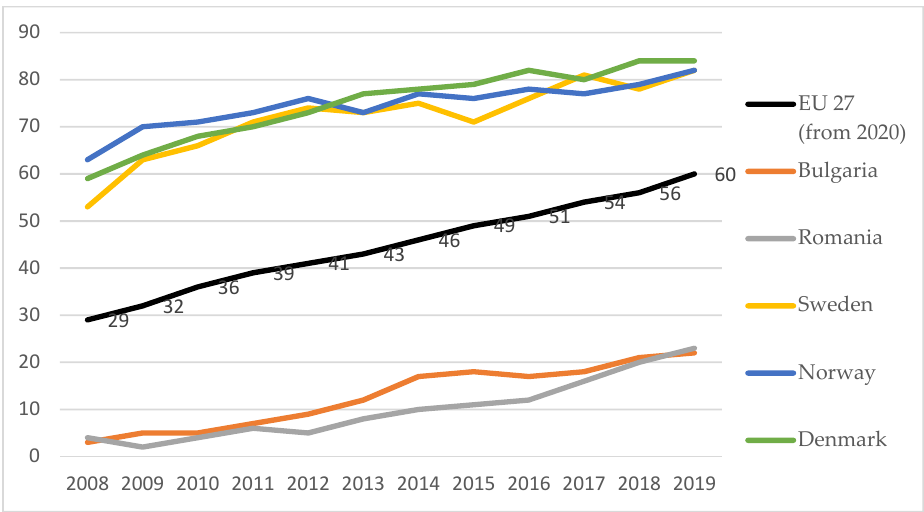
Figure 8. Individuals having ordered/bought goods or services for private use over the internet in the last 12 months, average EU 27 and extreme performance by countries as a percentage of individuals. Source: Authors projection using Eurostat database. Data extracted on 12 September 2021 online data code: TIN00096—Buy or order for private use. Within the last 12 months prior to the survey. Manually typed e-mails are excluded.